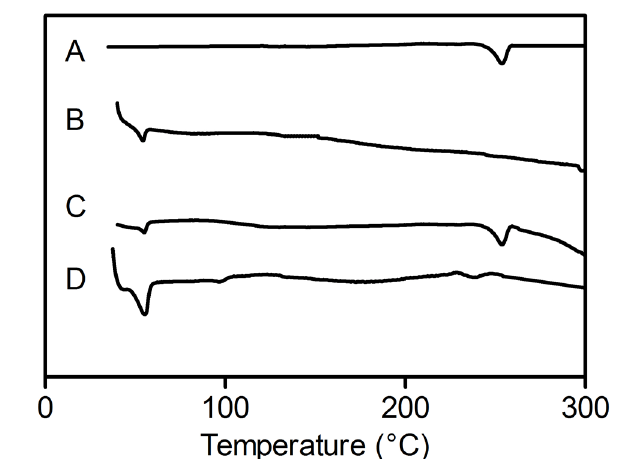
FIGURE 4 - DSC curves of (A) CA; (B) PLGA; (C) physical mixture; (D) CA-loaded PLGA implant.